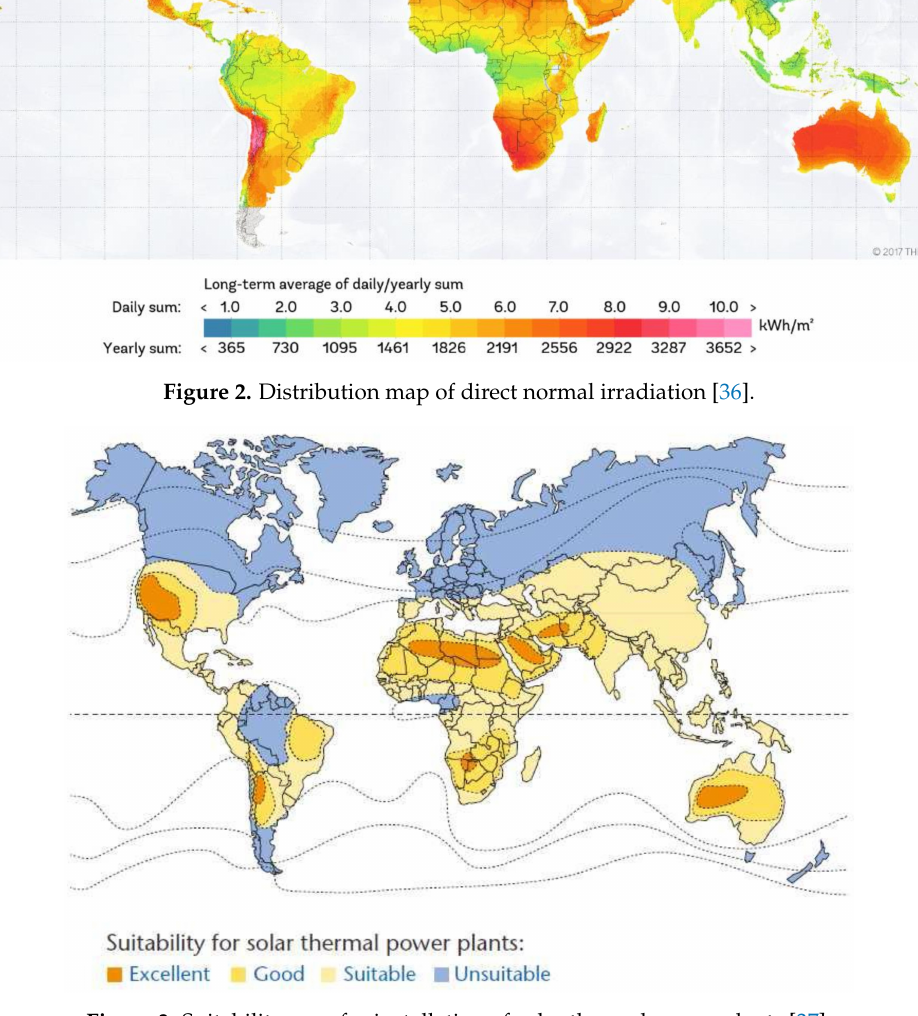
Figure 3. Suitability map for installation of solar thermal power plants